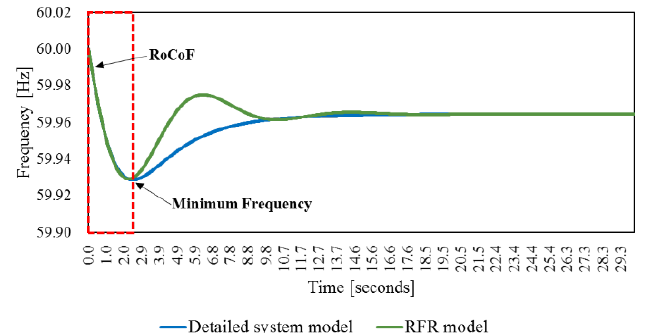
Figure 2. Comparison between frequencies calculated based on detailed system model and RFR model.